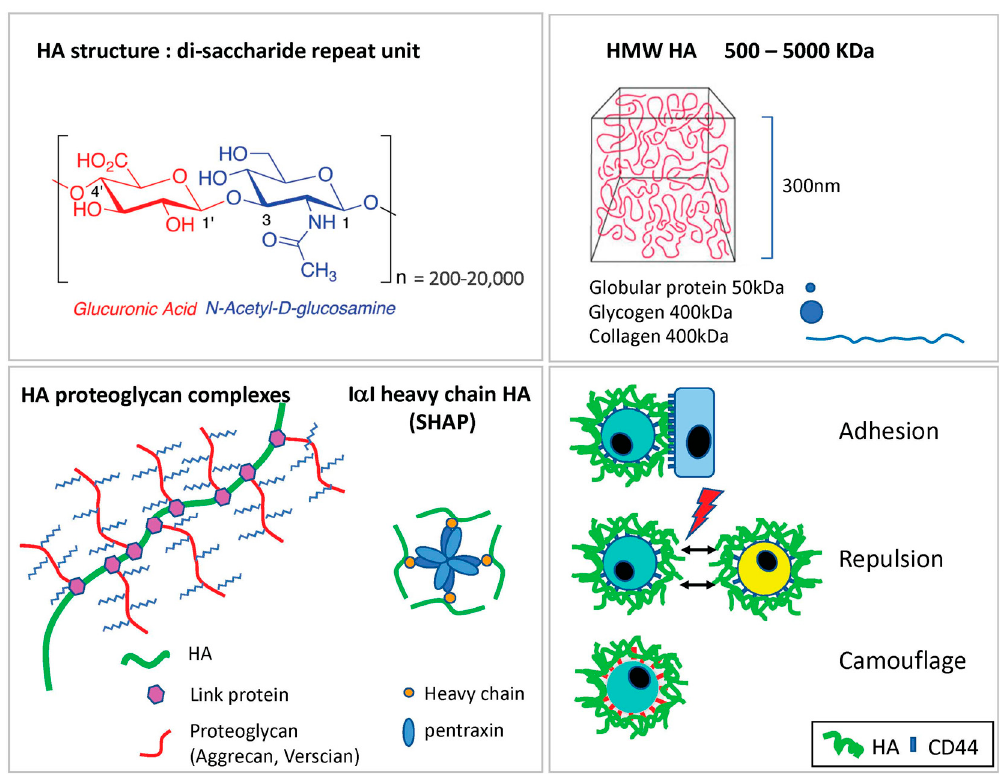
Figure 1. Structure and properties of HA. Top left and right panels, respectively, show the basic disaccharide repeat unit of long unbranched HA chains (represented in chair conformation) and the 3D volume occupied by a typical HMW HA chain (example shown is a 5000 kDa polymer) relative to average-sized globular proteins and larger globular/fibrous macromolecules depicted in 2D. Bottom left panel shows an illustration of a large noncovalent HMW HA complex containing the chondrotin sulphate proteoglycans aggrecan, versican and Link protein typical of those found in extracellular/pericellular matrices surrounding, e.g., chondrocytes in connective tissue anchored by CD44, and an inflammation-induced I α I heavy chain covalent HA complex (a.k.a. SHAP, serum HA associated protein) containing the cross-linking tetramer pentraxin. Formation of SHAP is catalysed by the small HA-binding protein TSG-6, which forms transient covalent intermediates with HA (not shown), but TSG-6 can also form cross-linked noncovalent complexes that have enhanced binding avidity for LYVE-1 and CD44 [49,50] (see text for details). Bottom right panel shows the different consequences of HA glycocalyx formation on cell behaviour including adhesion to neighbouring cells expressing appropriate HA receptors, repulsion by neighbouring cells with similar HA glycocalyces and camouflage of surface receptors and adhesion molecules depicted as red boxes, beneath the canopy formed by the HA glycocalyx.